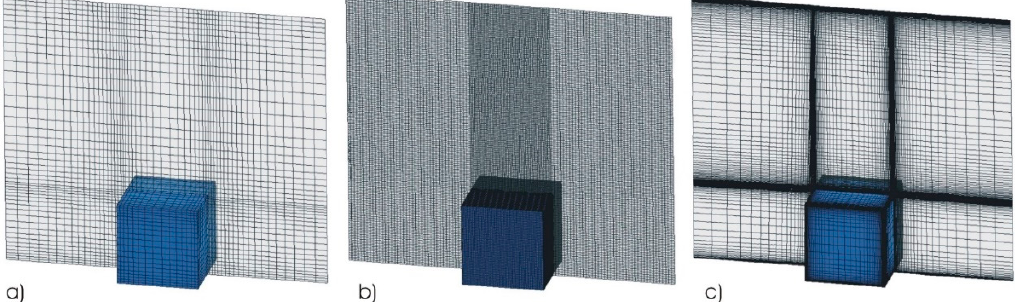
Figure 2. 2D view of the three different meshes used in the simulations: ( a ) uniform coarse-mesh, ( b ) uniform fine mesh and ( c ) non-uniform clustered mesh. Table 1. Models and grid sizes for the simulation of flow past an array of cubes. Model